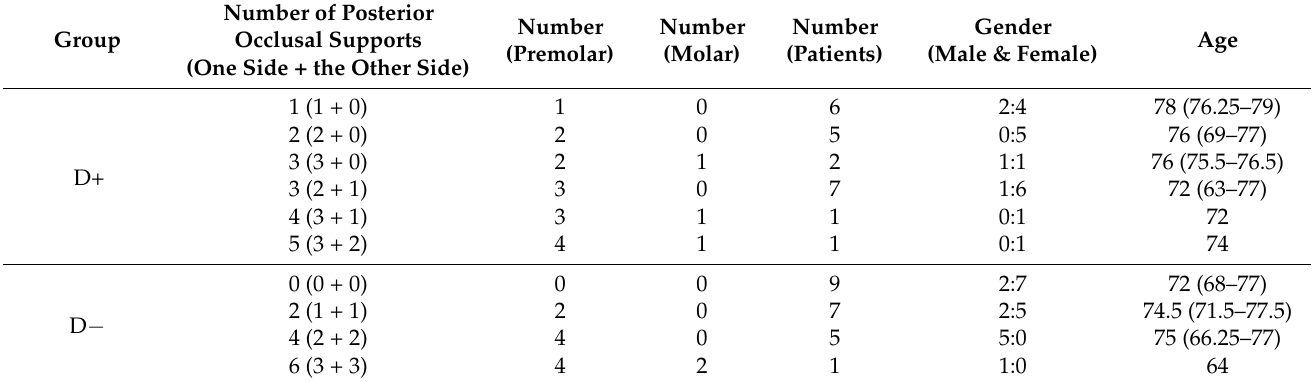
Table 2. Posterior teeth distribution in KC I D+ and D − patients.